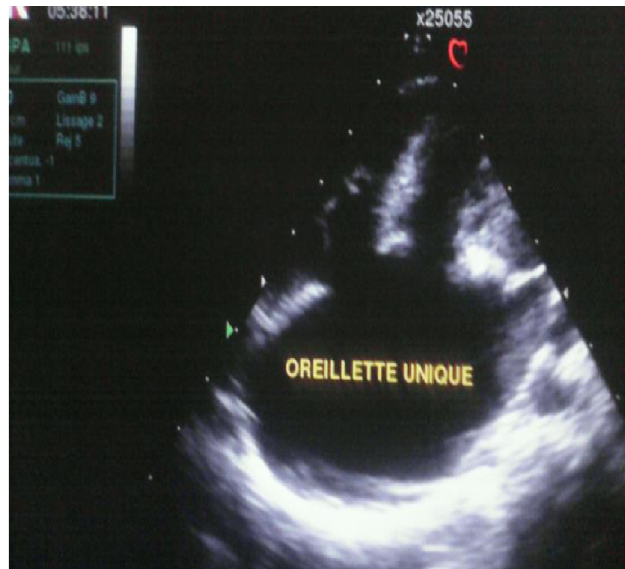
Fig. 5. Echocardiography showing congenital defects.